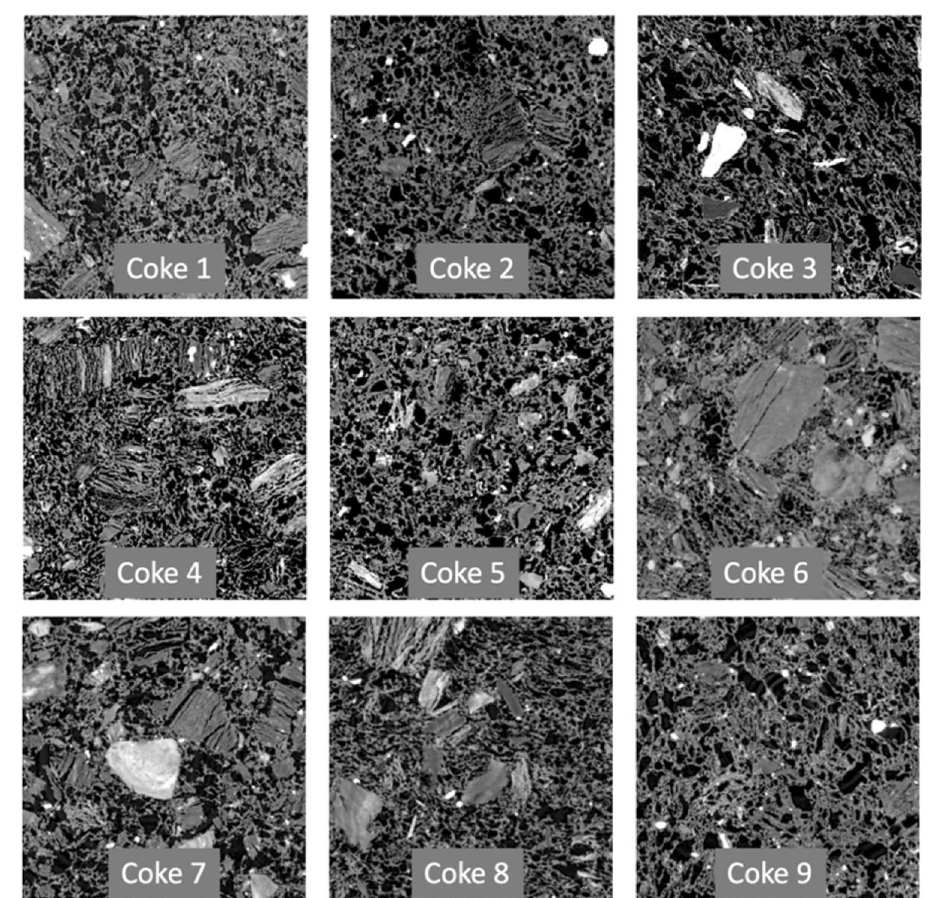
Fig. 2 Example 2D slices showing microstructure from the nine different cokes used in the study. Three samples of each coke were used